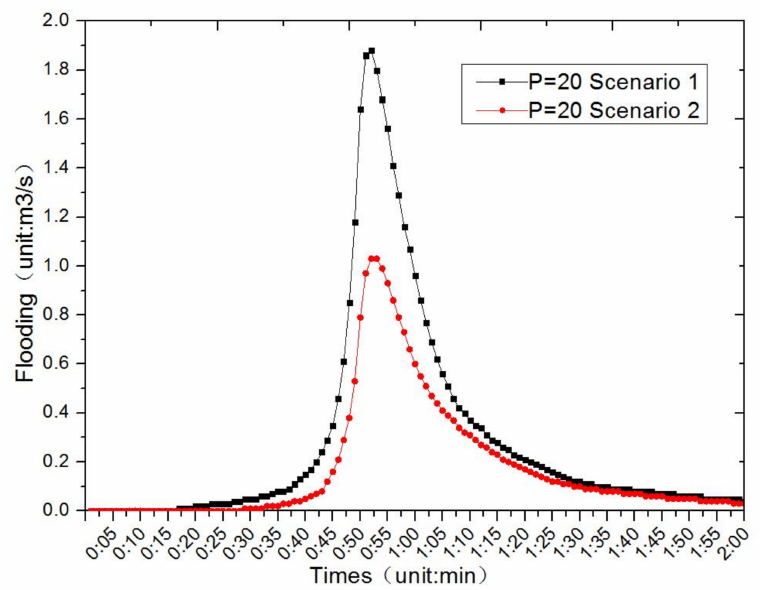
Figure 10. Comparison of the flooded areas for Scenarios 1 and 2 for a storm with a recurrence interval (P) of 20 years.